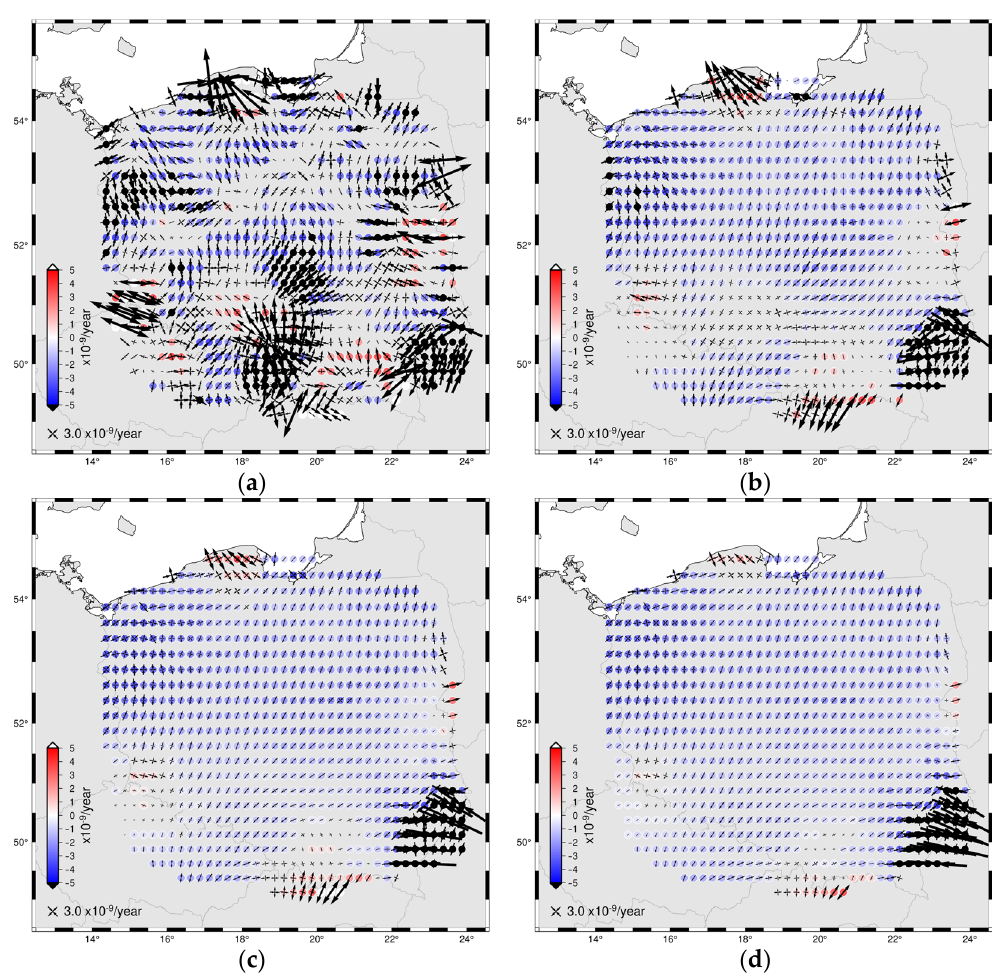
Figure 4. GPS strain rate maps including dilatation strain for different distance weighting functions. From the left: 50 km ( a ), 100 km ( b ), 150 km ( c ), and 200 km ( d ). The colors used represent the dilatation. Values of dilation below the standard deviation were removed from the map.